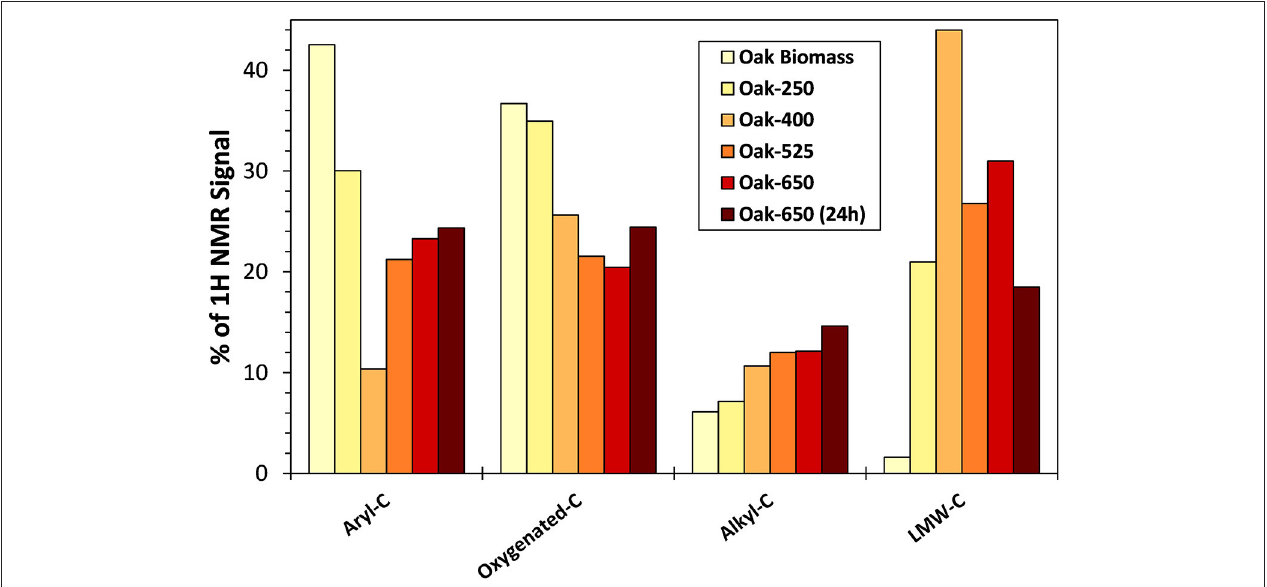
FIGURE 5 | 1 H-NMR functional group abundances in “Early” leachates of oak biomass and its biochar thermal series, calculated on a carbon basis. See the text for chemical group